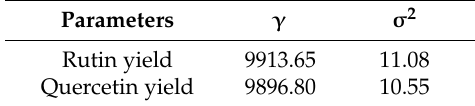
Table 1. The optimum parameter values of LS ‐ SVM model optimized by the IFOA.